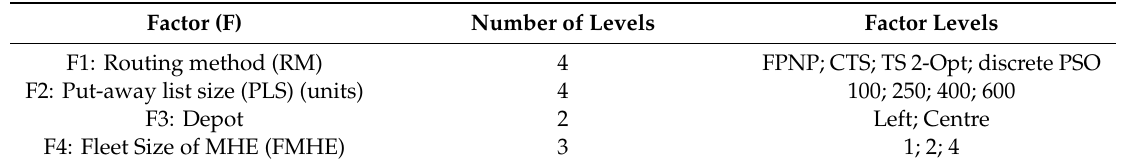
Table 2. Experimental factors for the